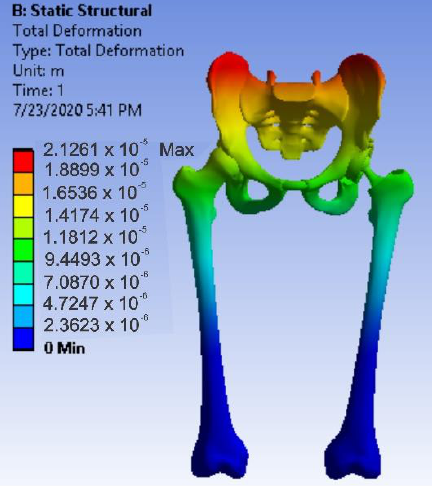
Figure 46. Displacement map for the system with morcellated bone graft.